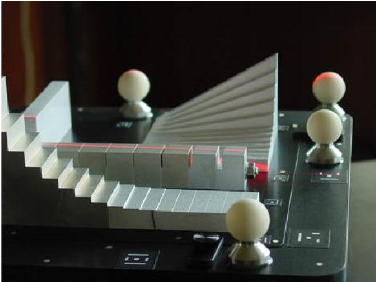
Figure 5. 3D imaging of the test artefact with a laser scanner in action.